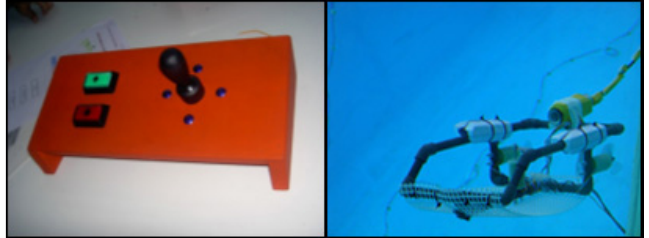
Figure 9. ( Left ) Control unit. ( Right ) Finished chassis.